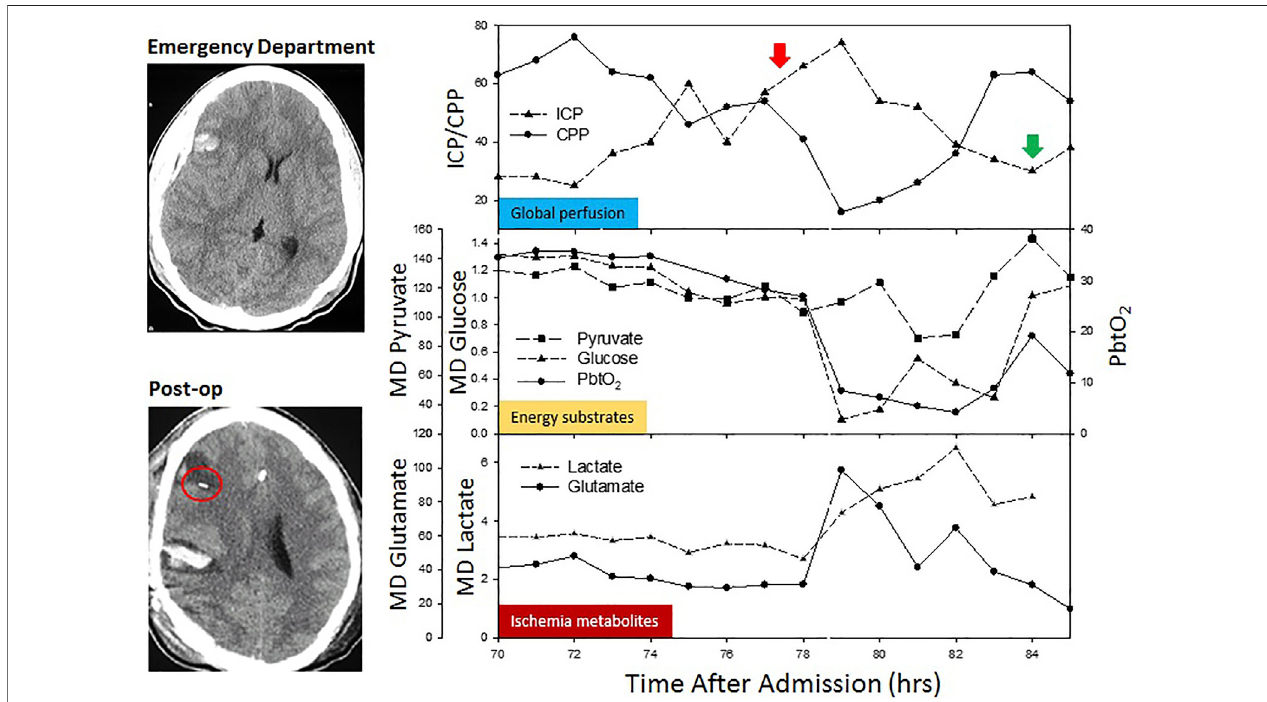
FIGURE1| Classicneurophysiologicchangesobservedduringanacute episodeofincreasedintracranial pressureinapatientundergoing multimodalmonitoring. A computed tomography demonstrates pre- and post-MMM probes placement in the penumbra of the intracerebral contusion. As ICP increases (red arrow) and CPP drops, there is a reduction in energy substrates (glucose and PbtO 2 ), with a parallel elevation in ischemia metabolites (lactate and glutamate). As the ICP crisis is temporized (green arrow), energy substrates and ischemia metabolites return to pre-crisis values.